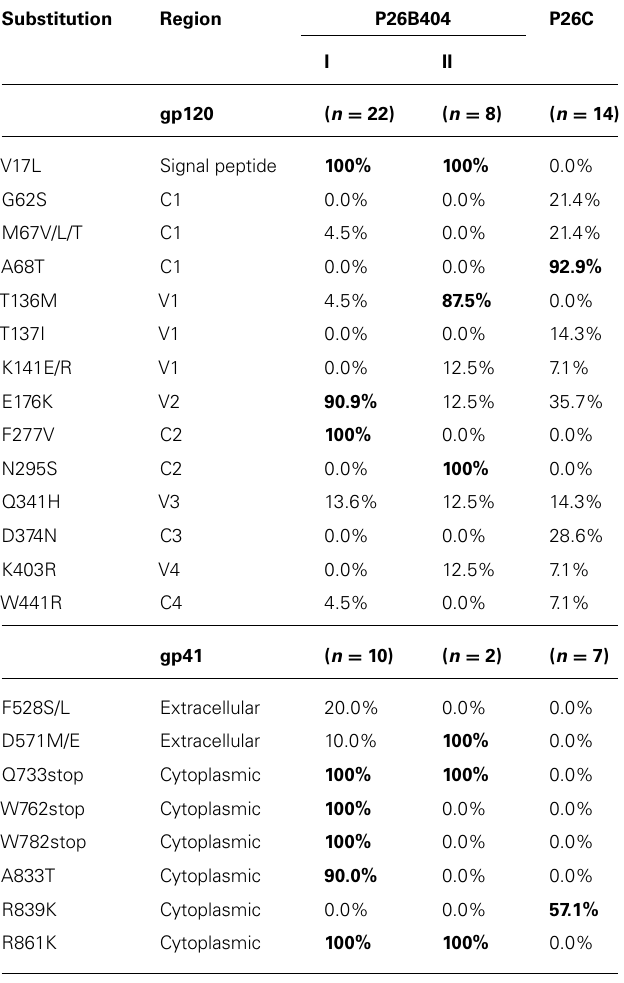
*Percentages of substitutions in populations P26B404 and P26C, which were obtainedafter26passagesinthepresenceandabsenceofB404,respectively,are shown.The P26B404 population is separated into two subpopulations according to the phylogenetic analysis in Figure 1 . All the substitutions that are observed in more than one clone are shown here. Boldface indicates substitutions dominant ( > 50%) in each population. The numbers of clones analyzed for the gp120 and gp41 regions are shown in parentheses.